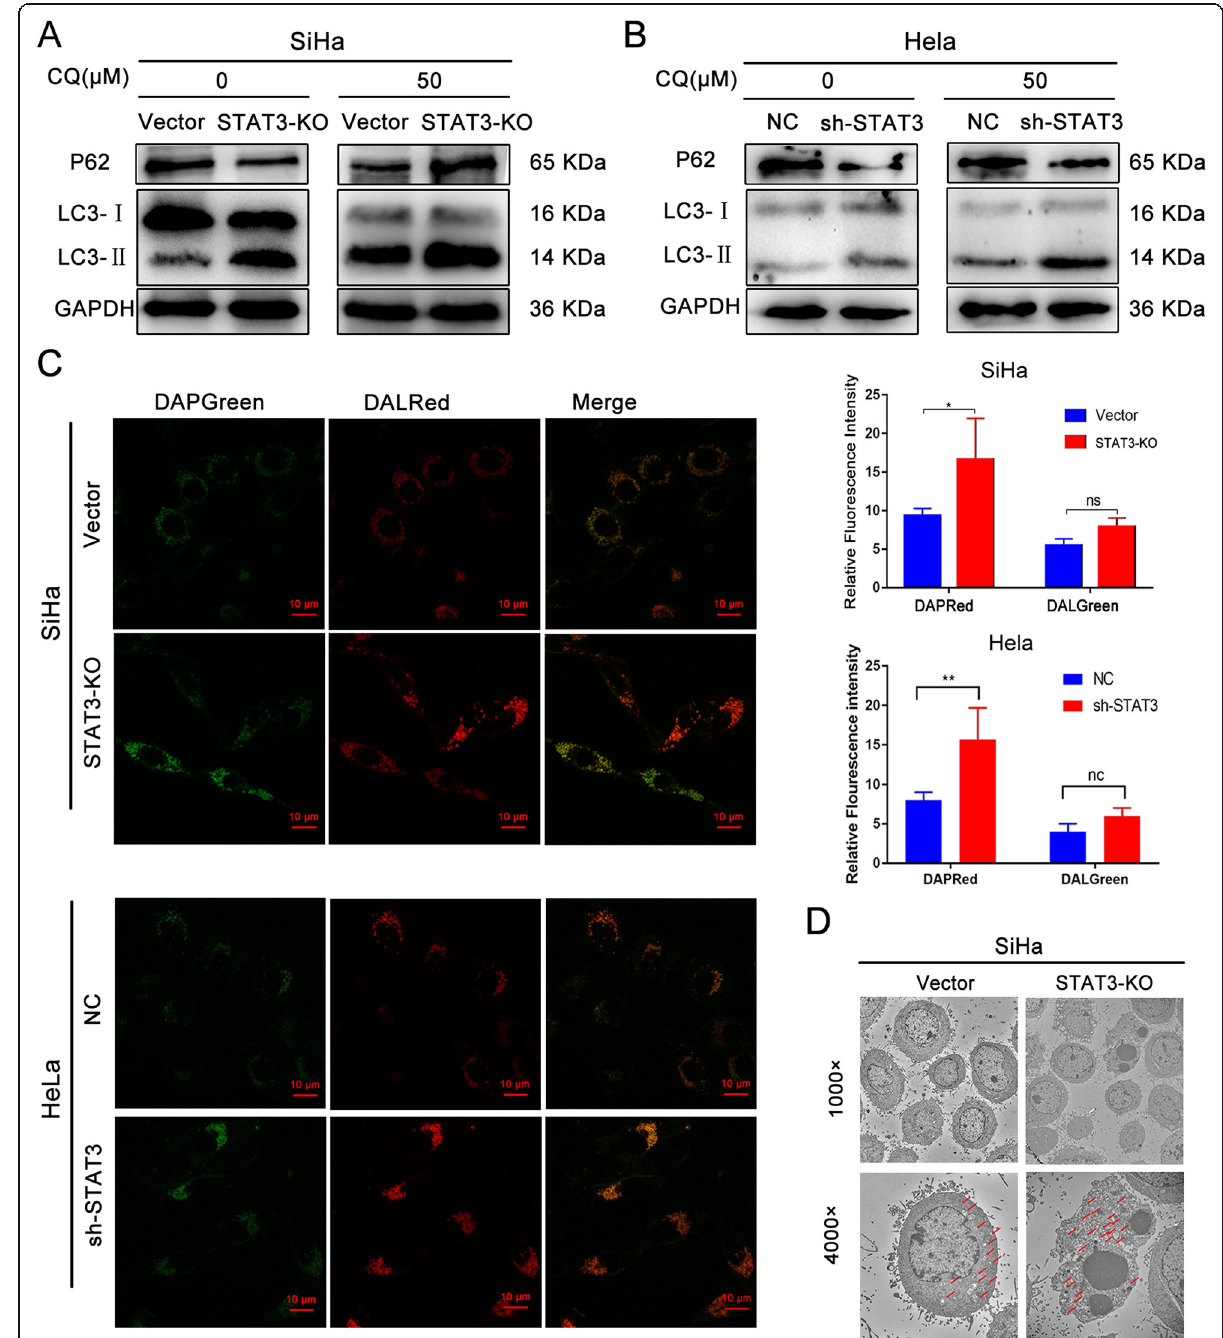
Fig. 3 STAT3 inhibits autophagy level of cervical cancer cells. A and B The autophagy marker proteins in cervical cancer cells treated with or without chloroquine were detected by western blotting; C The autophagosomes and autolysosomes were observed under Inverted Confocal Fluorescence Microscope; Semi-quantitative fluorescence of “ C ” . D . The autophagosomes were observed by electron microscope (red arrow: autophagosomes or autolysosomes); ( “ ns ” no significance, “ * ” p